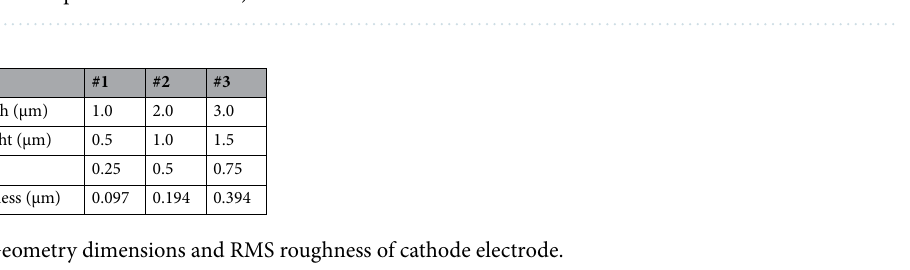
Figure 3. ( a ) The geometry of Ni electroplating model, and ( b , c , d ) the cathode electrode shape of 3 cases (dimensions are represented in Table 3).